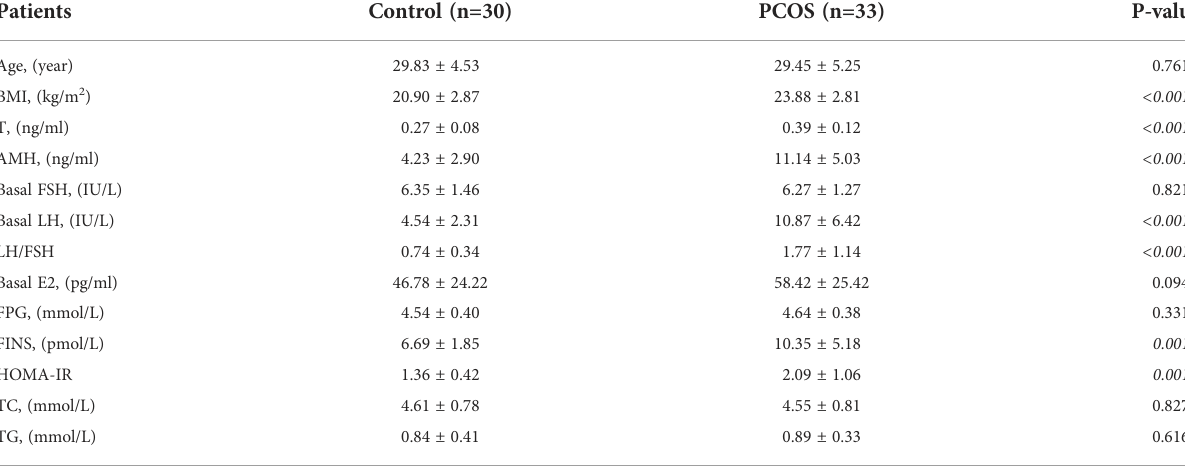
TABLE 1 Clinical and biological characteristics of PCOS patients and healthy controls.